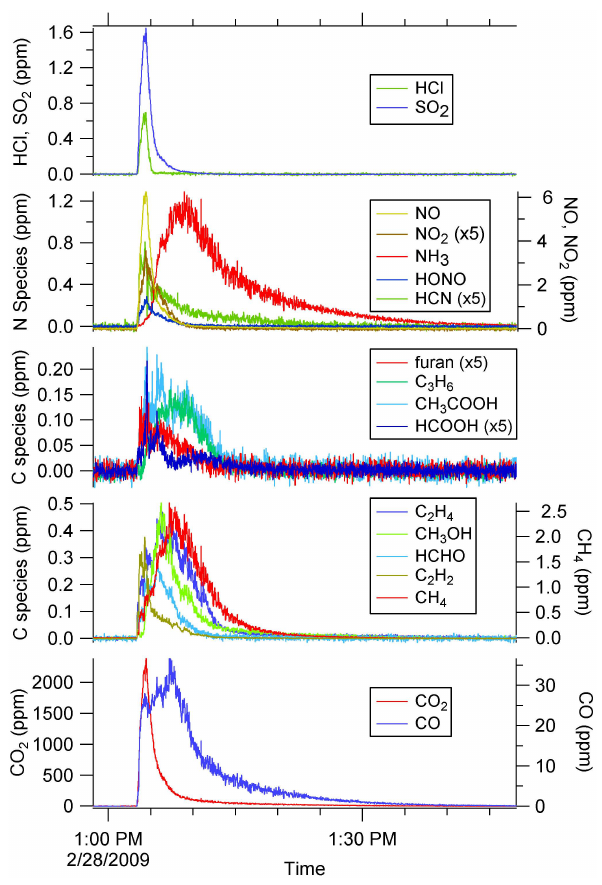
Fig. 2. Excess mixing ratios of 18 compounds over time for a typ- ical fire as measured quantitatively by OP-FTIR from a California sage fuel